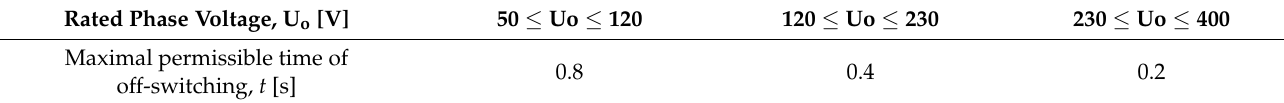
Table 1. Maximal permissible times of off-switching in the TN system.